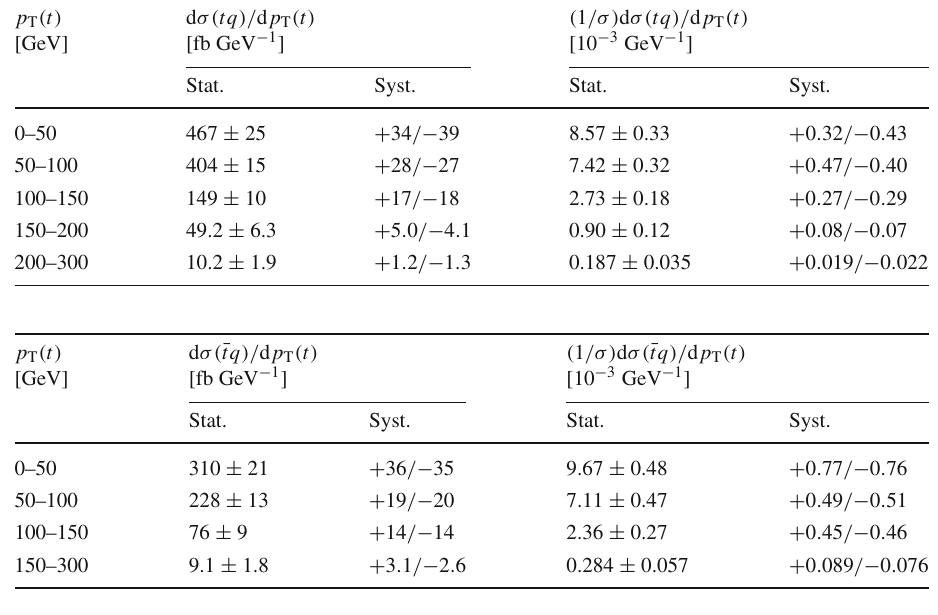
normalised unfolded differential tq production cross-section as a function of p T ( t ) at parton level